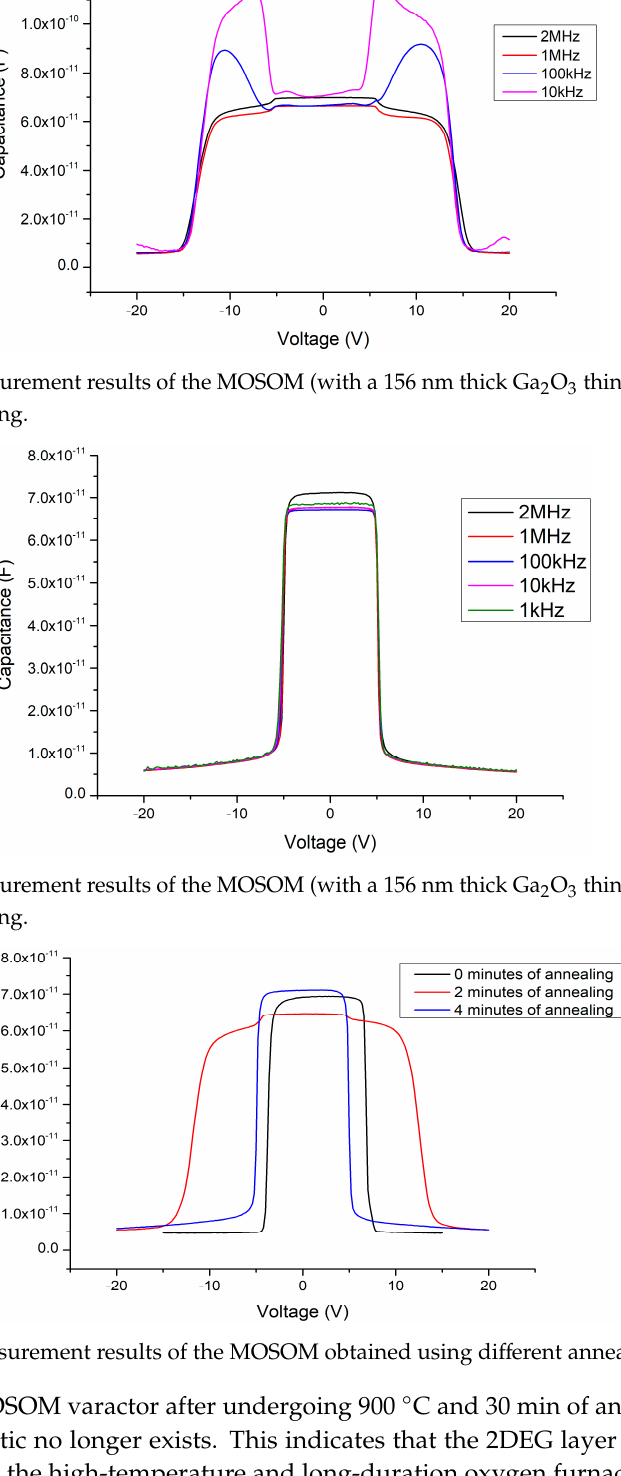
Figure 17. C–V measurement results of the MOSOM (with a 156 nm thick Ga 2 O 3 thin film) after 500 °C and 2 min of annealing.